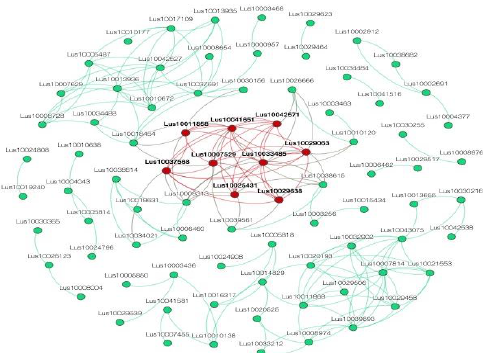
Figure 4. The network of most highly connected candidate genes. A node size is proportional to its adjacency value. Red node color defines gene membership in a subnetwork.